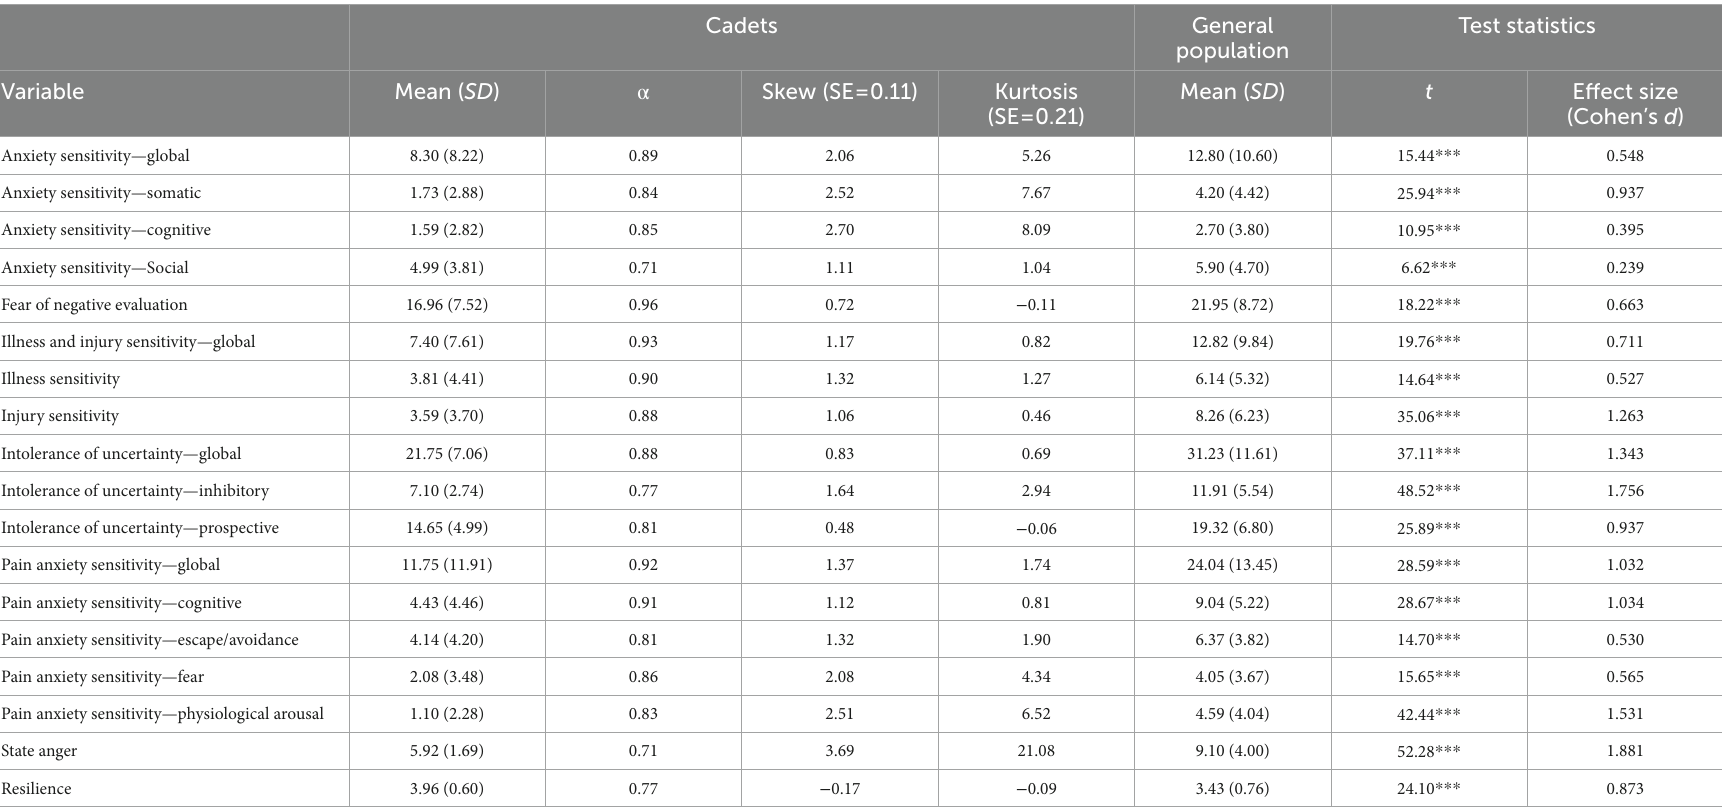
TABLE 1 Putative risk and resilience factor between-group differences among cadets and the general population.